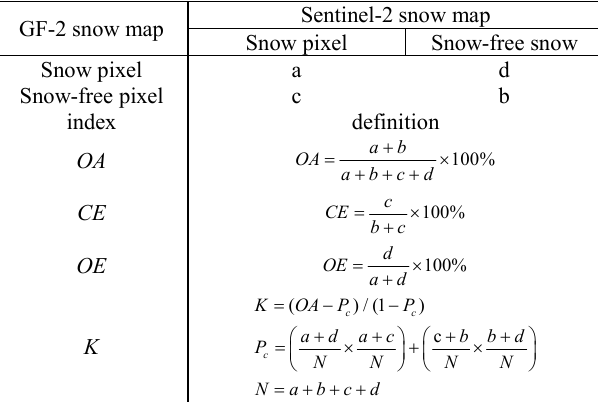
Table 2. Definition of confusion matrix and evaluation